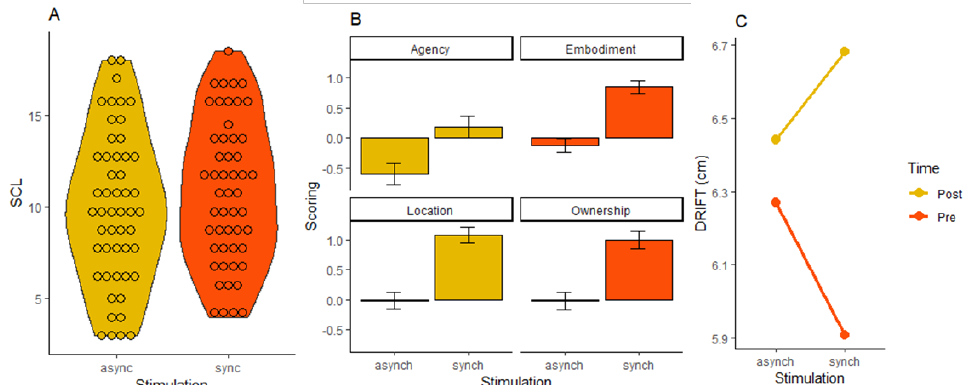
Figure 2. Results of Experiment 1. ( A ) Main effect of Stroking Mode for electrodermal activity. On the x -axis, the two levels of the variable Stroking Mode are represented while skin conductance level (SCL) is shown on the y -axis. Each point of the violin plot represents a subject; ( B ) Main effect of Stroking Mode for Embodiment Questionnaire. Participants showed an overall stronger body awareness while receiving the synchronous touch compared to the asynchronous one. On the x -axis, the two levels of the variable Stroking Mode are plotted while the scoring reported in the embodiment questionnaire is depicted on the y -axis. From the left top box to the right bottom one: Agency, Embodiment, Location, and Ownership. Error bars represent standard errors of the mean; ( C ) significant two-way interaction between Stroking Mode and Time for Proprioceptive Drift. The proprioceptive drift towards the rubber hand location was larger after the synchronous stroking than before it. On the x -axis, the two levels of the variable Stroking Mode are represented while proprioceptive drift (cm) is denoted on the y